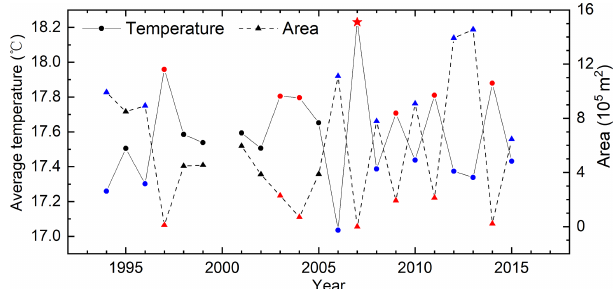
Figure 4. Time series of mean water temperature (solid line) and vertical cross-section area (broken line) of the Iyo-Nada bottom cold water mass (INCWM) in July during 1994–2015. A strong IN- CWM year is marked by blue, while a weak INCWM year is marked by red. The red star indicates that we did not identify a BCWM in 2007 because the water temperature was higher than 18 ◦ C along the entire transect. For this case, we used the observed temperature (18.23 ◦ C) at the average location of the INCWM (50m depth at station 3) as the average temperature and specified a zero